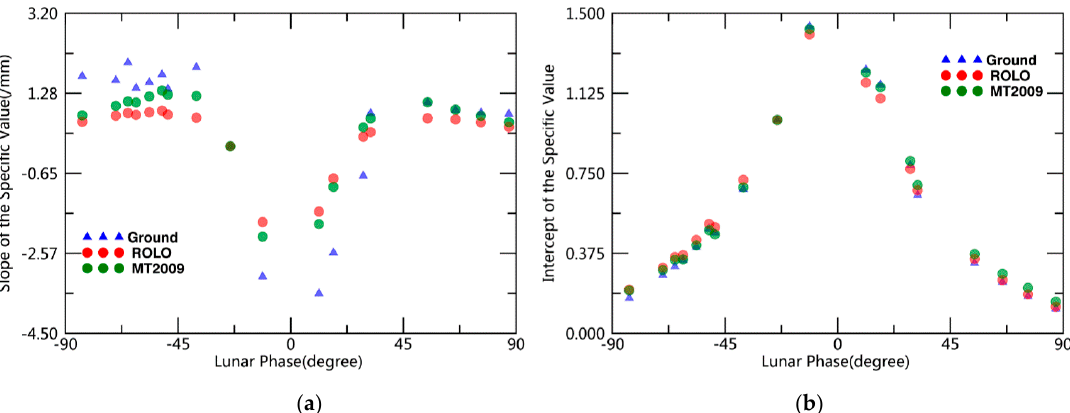
Figure 20. Comparison between measurements and models in phase reddening. ( a ) Intercept of the specific values as a function of lunar angle θ , and ( b ) slope of the specific values as a function of lunar angle θ . Three color symbols represent ROLO model, MT2009 model, and ground-based measurement.